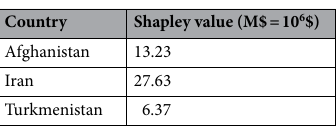
Table 1. Shapley value of countries.